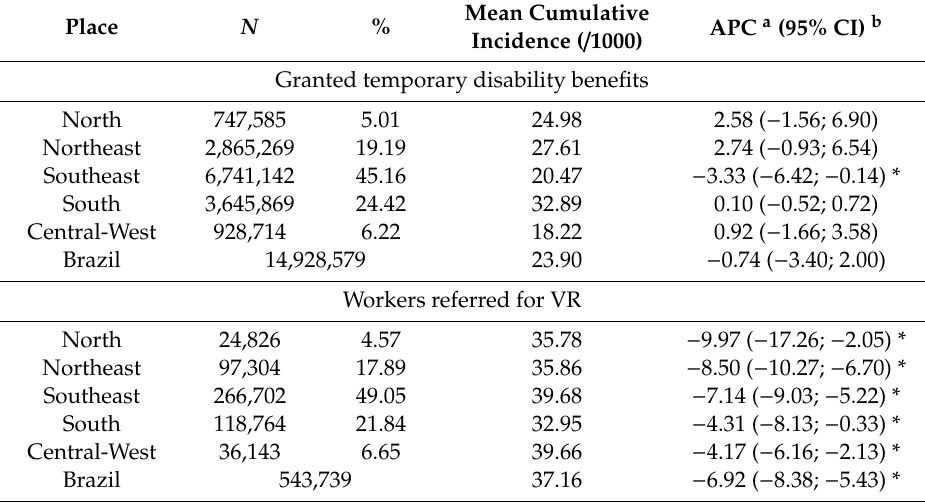
Table 1. Absolute and relative frequencies and mean cumulative incidence rates and trends relative to temporary disability benefits granted and workers referred to National Institute of Social Security (INSS) vocational rehabilitation services. Brazil and macro-regions, 2007–2016. Mean Cumulative Place N % APC a (95% CI) Incidence ( / 1000)